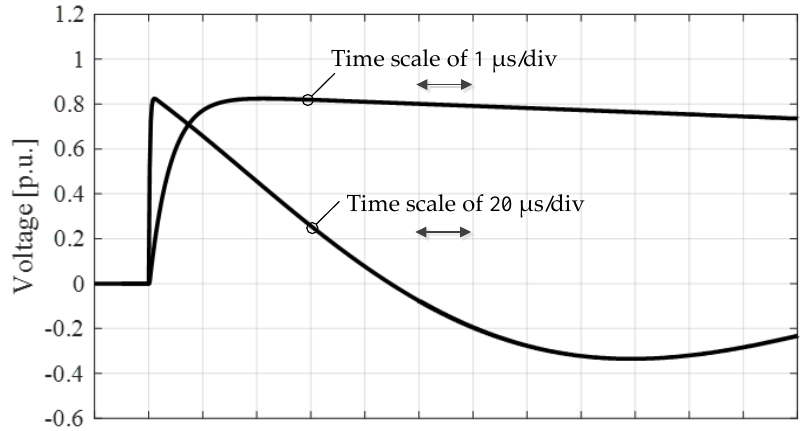
Figure 11. Generated waveform of Case 7 in Table 4 and by the proposed approach.